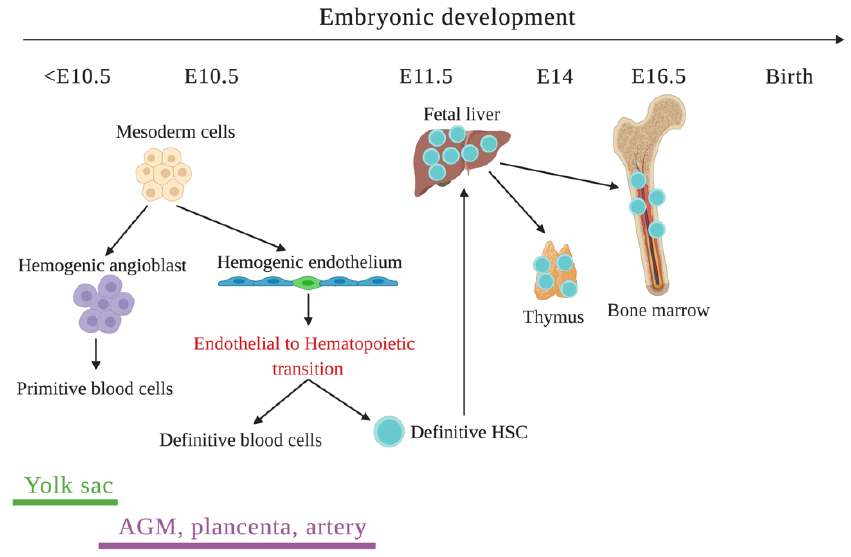
Figure 3. Hematopoiesis during murine embryonic development.